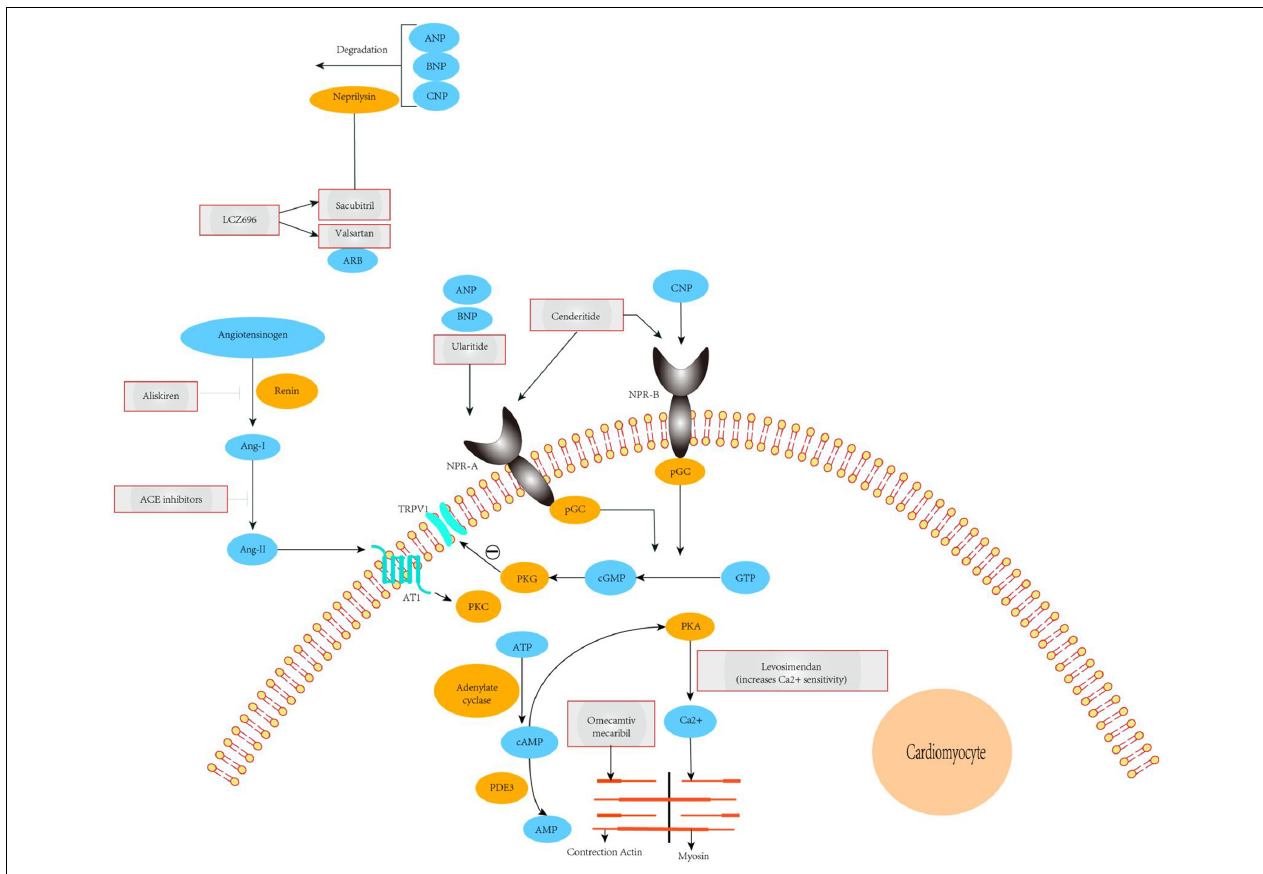
FIGURE 2 | Mechanisms of action of novel therapeutics for heart failure. The ARNi LCZ696 is split into the ARB valsartan and the neprilysin-inhibitor sacubitril. Valsartan abrogates signaling via the AT1 receptor, inhibiting deleterious effects mediated by Ang-II such as vasoconstriction, hypertrophy, and fibrosis in major cardiovascular organs. Sacubitril prevents breakdown of endogenous natriuretic peptides (ANP, BNP, and CNP), thereby augmenting their beneficial actions in cardiovascular disease. The overall effects of ARNi are vasodilatation, natriuresis, and diuresis, as well as inhibition of fibrosis and hypertrophy. Ularitide selectively targets NPR-A, whereas cenderitide activates both NPR-A and NPR-B. Both peptides increase intracellular cGMP, which in turn leads to inhibition of the renin-angiotensin-aldosterone system and attenuation of fibrosis, hypertrophy, and vasoconstriction. Our proposed model shows that TRPV1 interacting with NPR-A, activation of the NPR1 and ANP pathway leads to cGMP-dependent stimulation ofTRPV1 phosphorylation. PDE3 antagonists (enoximone, milrinone), calcium sensitizers (levosimendan), and a direct activator of cardiac myosin (omecamtiv mecarbil). ACE, angiotensin-converting enzyme; TRPV1, transient receptor potential cation channel subfamily V member 1; Ang-I/II, angiotensin I/II; ARB, angiotensin-receptor blocker; ARNi, angiotensin receptor-neprilysin inhibitor; AT1, type-1 angiotensin II receptor; ANP, A-type natriuretic peptide; BNP, B-type natriuretic peptide; CNP, C-type natriuretic peptide; NPR-A/B, atrial natriuretic peptide receptor 1/2; PDE3, phosphodiesterase-3; pGC, plasma- membrane-bound guanylate cyclase; PKA, protein kinase A; PKC, protein kinase C; PKG, protein kinase G; pGC, plasma- membrane-bound guanylate cyclase; sGC, soluble guanylate